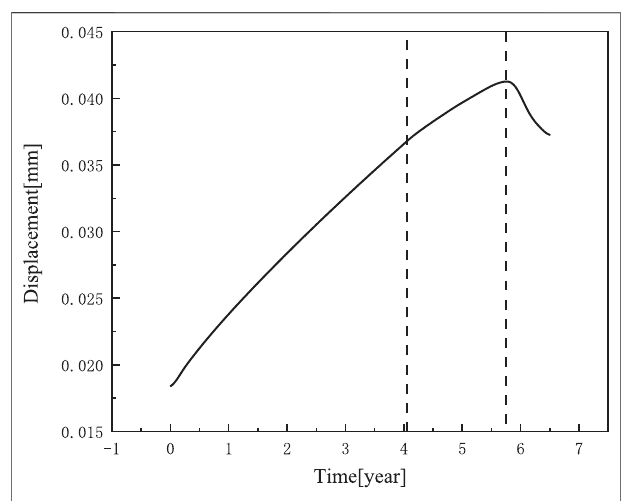
FIGURE13| The displacementofthe inner surface ofpellet versus